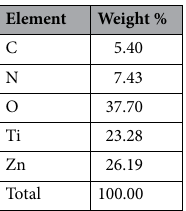
Table 1. Percentage of elements in T1 ‒ Z1/CS.